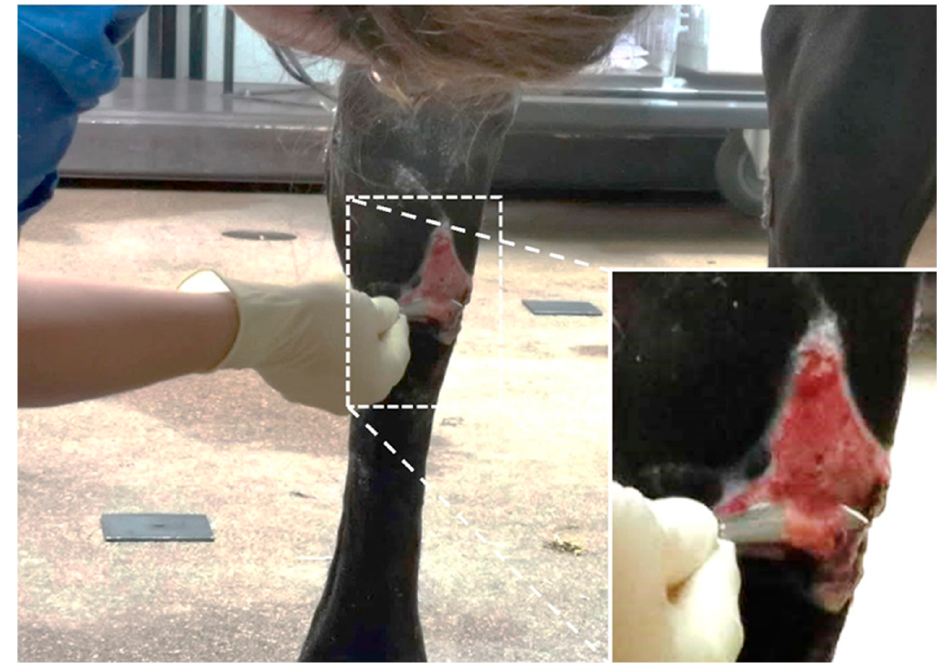
Figure 1. Picture of an 8-year-old mare, which came to the clinic with a hypergranulating wound at the distal aspect of the right tarsus. Exuberant granulation tissue is trimmed with a scalpel.